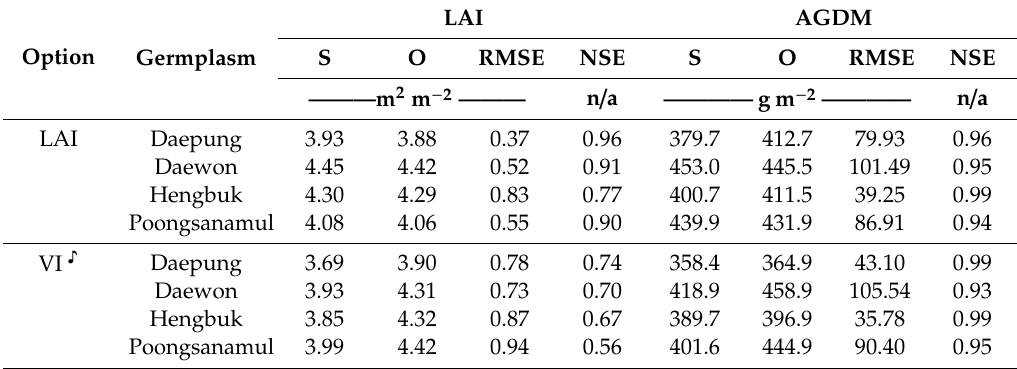
Table A3. Error statistics of root mean square (RMSE) and Nash–Sutcli ff e e ffi ciency (NSE) in comparison between simulated (S) and observed (O) of leaf area index (LAI) and above ground dry mass (AGDM) for soybean germplasms or cultivars, simulated with di ff erent input options (i.e., LAI or VI) for the